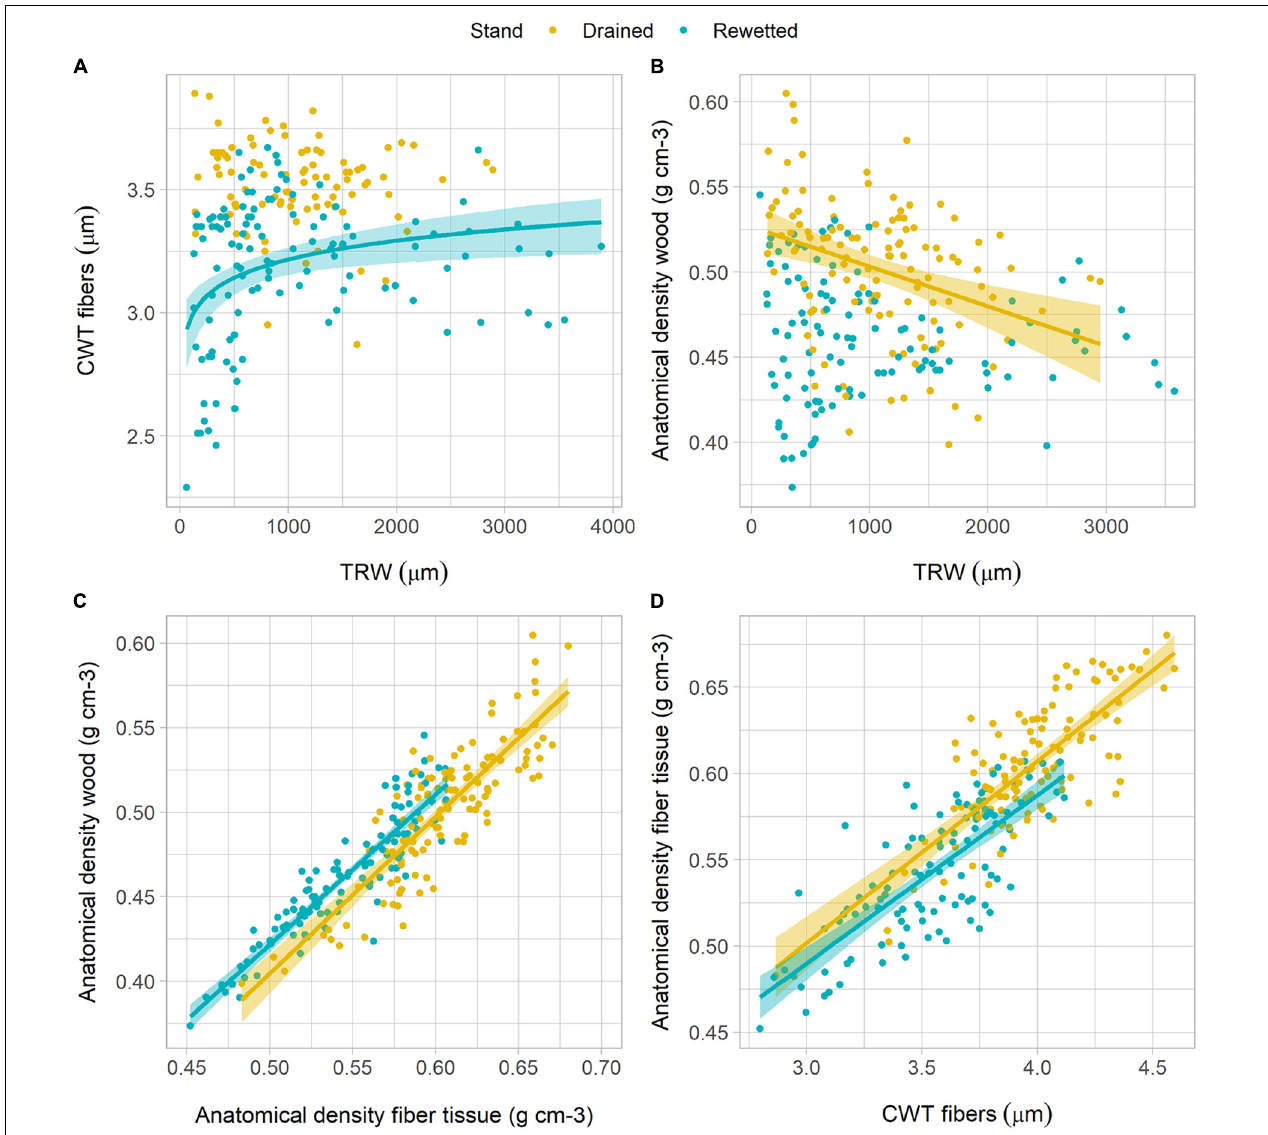
FIGURE 6 | Relationship between anatomical density parameters, cell wall thickness (CWT), and tree-ring width (TRW) in both stands. (A) Relationship between CWT and TRW; (B) relationship between anatomical wood density and TRW; (C) relationship between anatomical wood density and the density of the fibers; (D) relationship between the density of the fibers and CWT. Lines show regression fits and shadows indicate the 95% confidence interval of the model fit (refer to Table 2 for regression